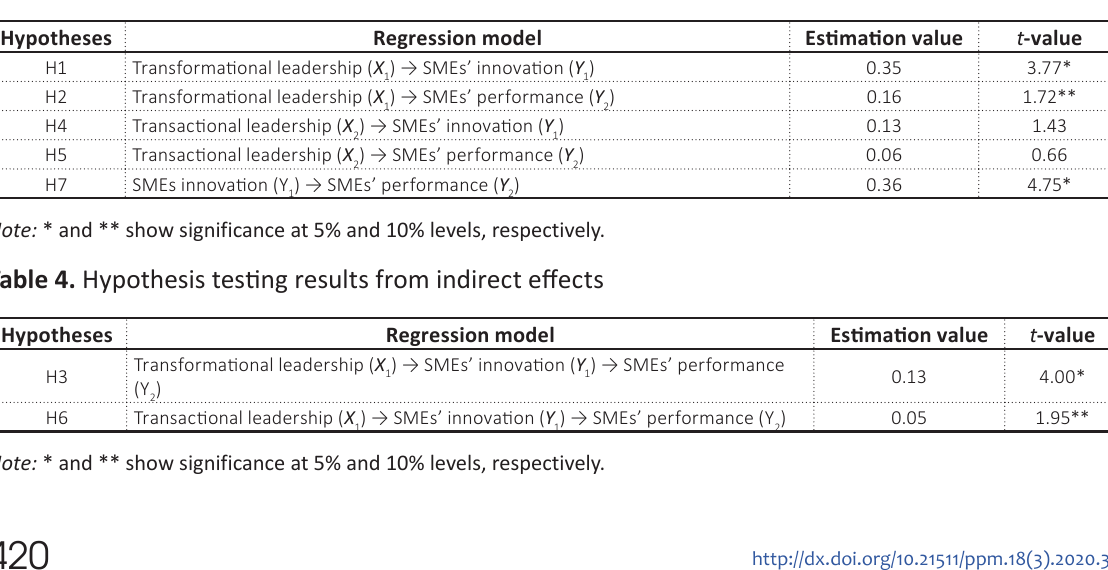
Table 3. Hypothesis testing results from the direct effect